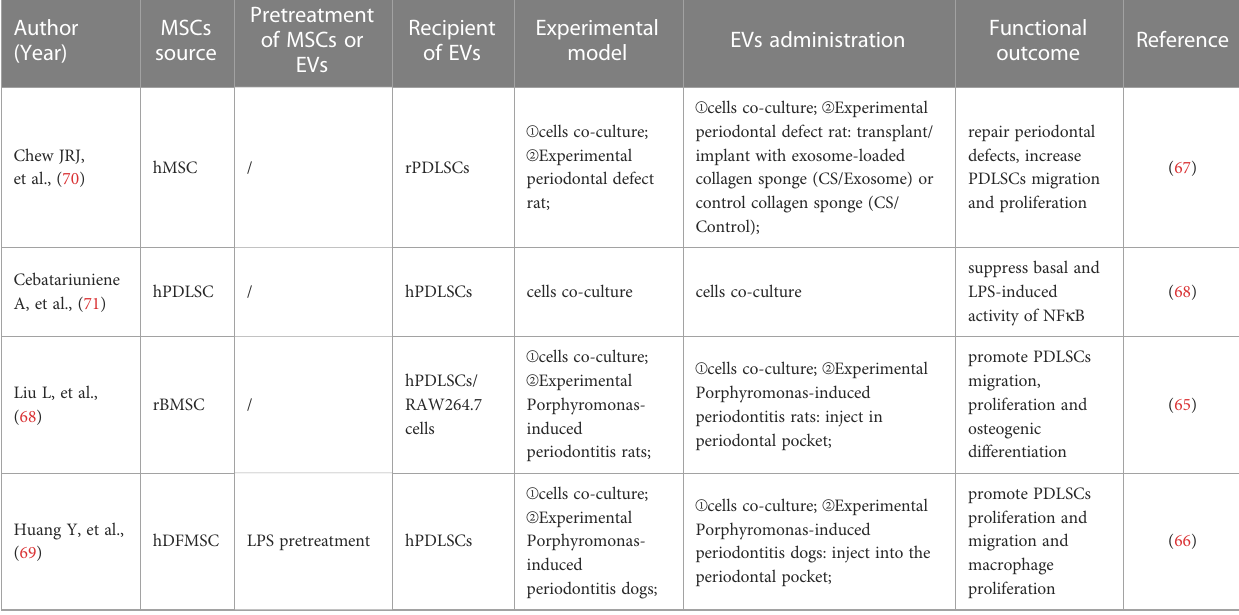
TABLE 2 Anti-in fl ammatory and immunomodulatory effects of stem cell exosomes in periodontitis.